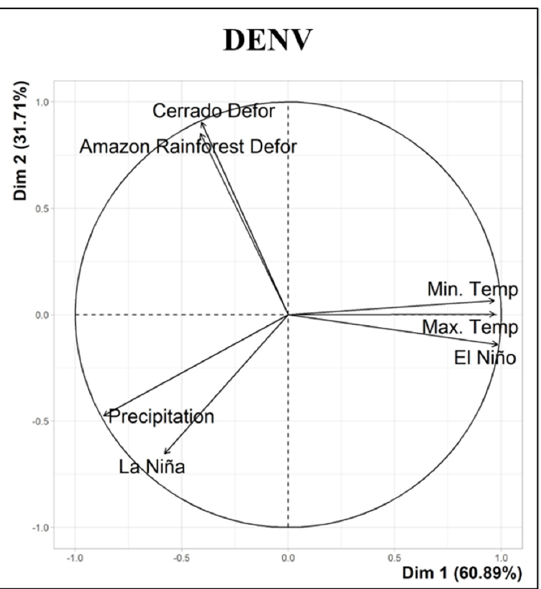
Figure 3. The most influential environmental variables. PCA for DENV showing the most influential environmental variables. Table 1. Importance of environmental variables for the cases of